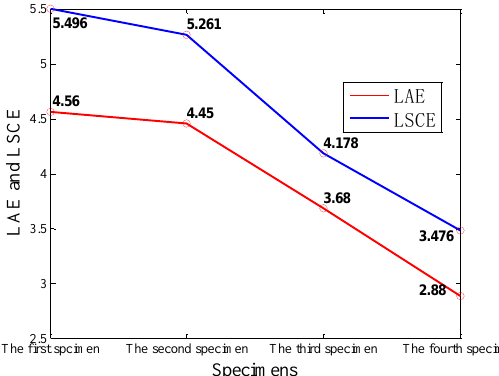
Figure 5. The results of the max LAE (logarithm of the average energy) and the max LSCE (logarithm of the slope of cumulative energy) in four specimens.